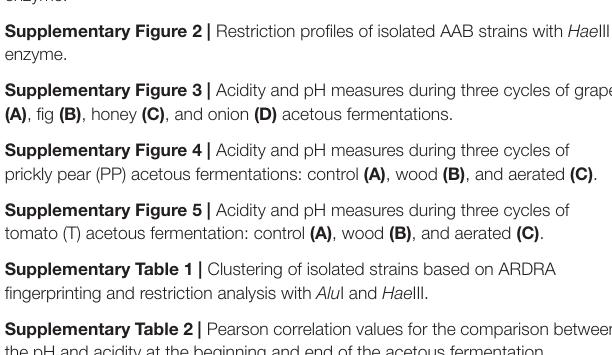
Supplementary Figure 1 | Restriction profiles of isolated AAB strains with Alu I enzyme. Supplementary Figure 2 | Restriction profiles of isolated AAB strains with Hae III enzyme. Supplementary Figure 3 | Acidity and pH measures during three cycles of grape (A) , fig (B) , honey (C) , and onion (D) acetous fermentations. Supplementary Figure 4 | Acidity and pH measures during three cycles of prickly pear (PP) acetous fermentations: control (A) , wood (B) , and aerated (C) . Supplementary Figure 5 | Acidity and pH measures during three cycles of tomato (T) acetous fermentation: control (A) , wood (B) , and aerated (C) . Supplementary Table 1 | Clustering of isolated strains based on ARDRA fingerprinting and restriction analysis with Alu I and Hae